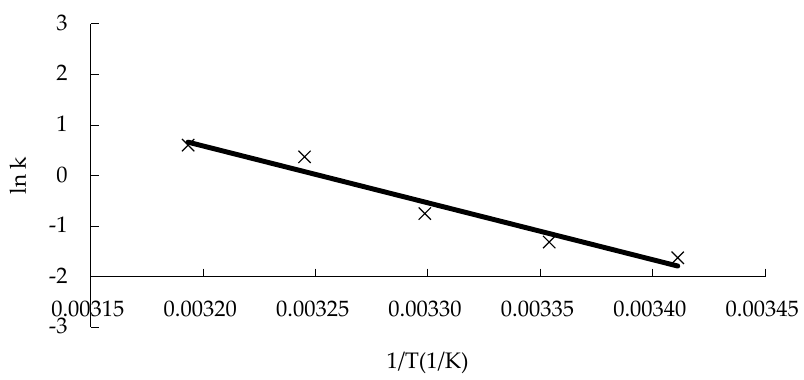
Figure 5. Arrhenius behaviour curve of “boba” ball quality.